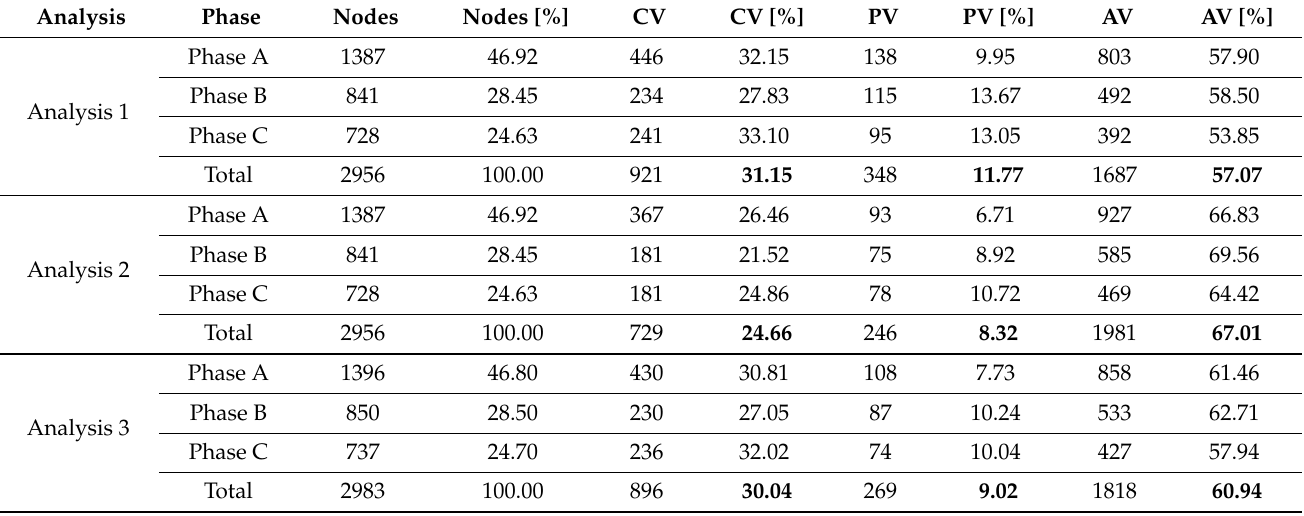
Figure 21. Analysis 3: ( a ) voltage rating and ( b ) voltage profile. Table 9 provides the voltage classification for all nodes of Feeder 14 for the three analyses performed, in which the percentages of critical, precarious, and adequate voltage are highlighted in bold. Each analysis resulted in different voltage ratings and different voltage profiles for the same installed capacity into the grid. The electrical losses were 13.57% for Analysis 1, 14.30% for Analysis 2, and 38.14% for Analysis 3. The highest percentage of nodes with an adequate voltage was 67.01%, obtained from Analysis 2. In this way, the same total installed capacity and different geographic locations of allocation of DGPV cause different impacts on the grid. Table 9. Impact of geographic location of distributed generation photovoltaic on Feeder